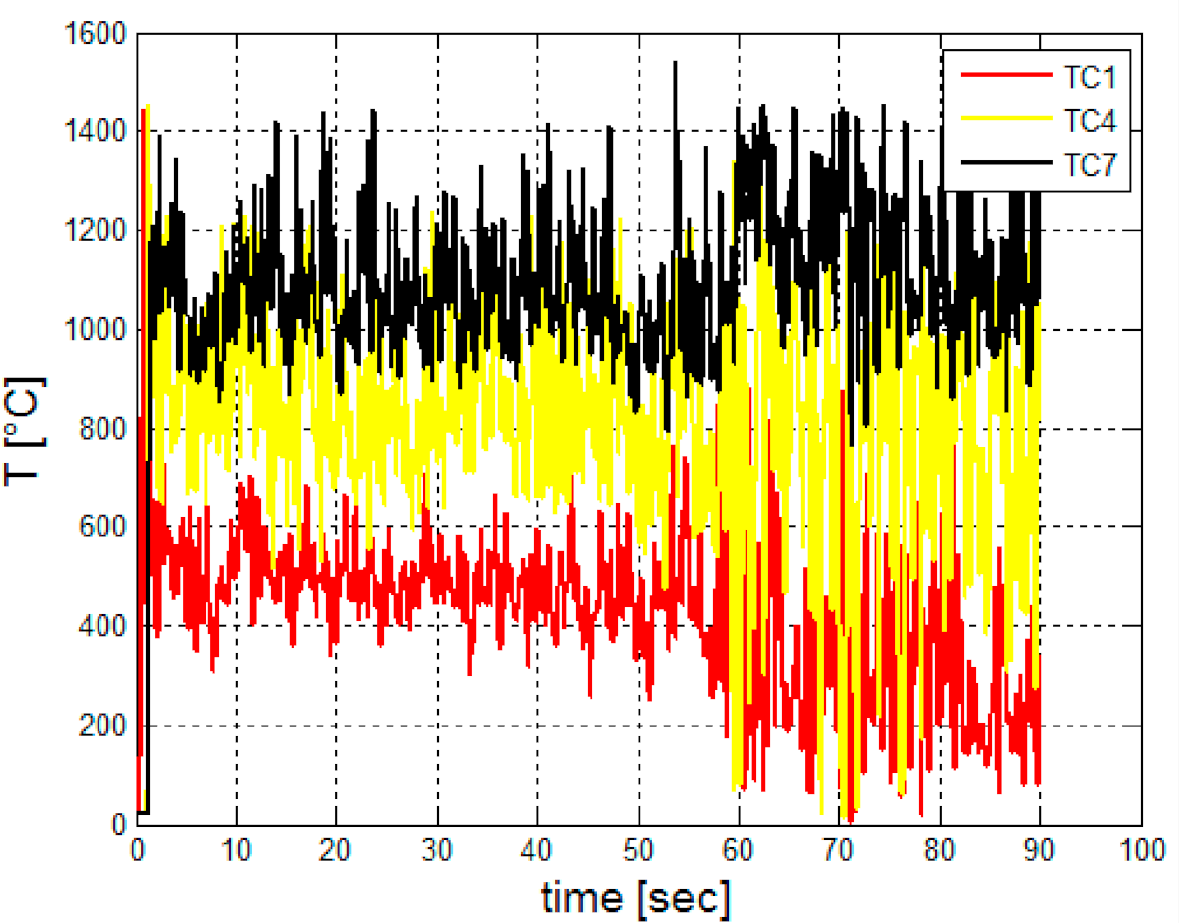
Figure 15. Temperature readings of three thermocouples inside the